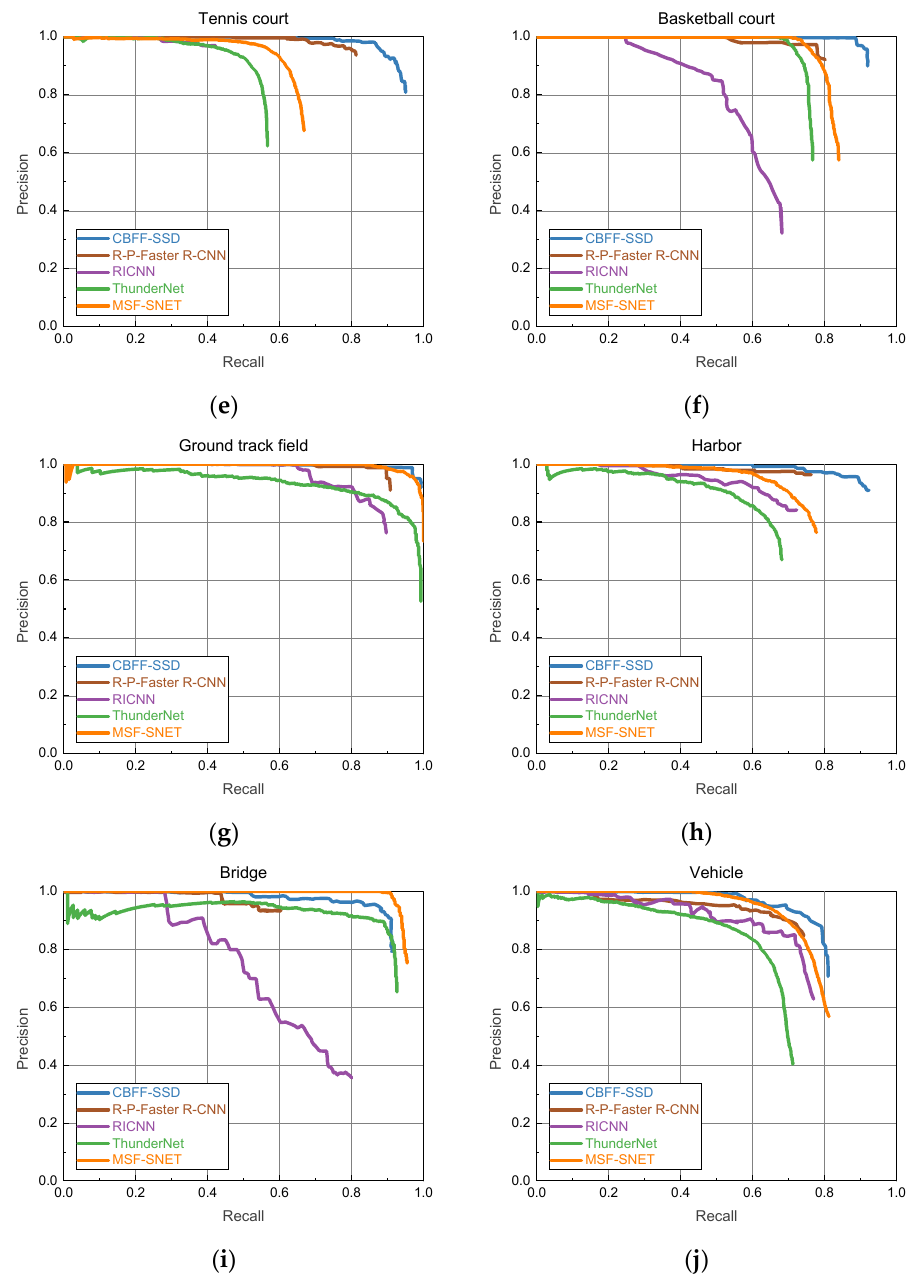
Figure 7. The precision recall curves of the proposed algorithm. ( a ) Airplane; ( b ) ship; ( c ) storage tank; ( d ) baseball diamond; ( e ) tennis court; ( f ) basketball court; ( g ) ground track field; ( h ) harbor; ( i ) bridge and( j ) vehicle.